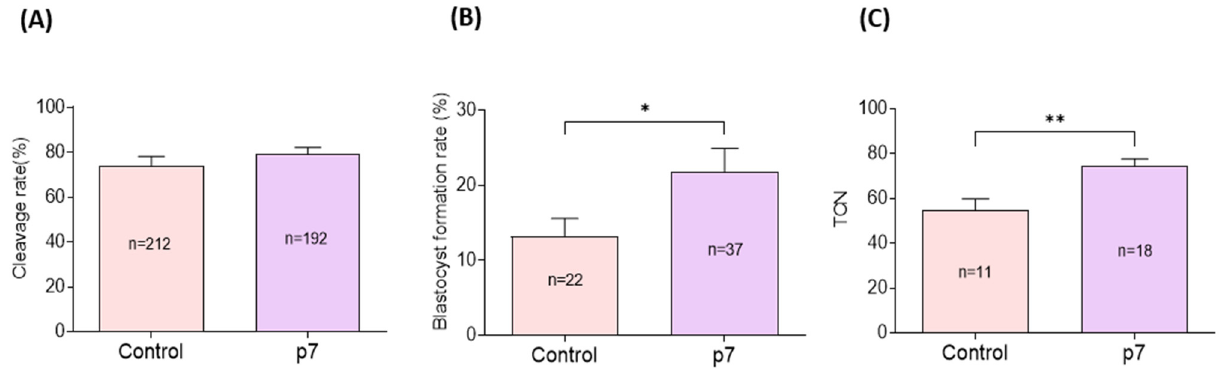
Figure 6. Effects of eAFMSC-CMp7 on porcine embryo development after in vitro fertilization. ( A , B ) The cleavage rates and blastocyst formation rates of IVF embryos on Day 2 and Day 6, respectively. ( C ) Total cell number per blastocyst of IVF embryo. The asterisks represent significantly different when compared to the control (*: p < 0.05, **: p < 0.01).